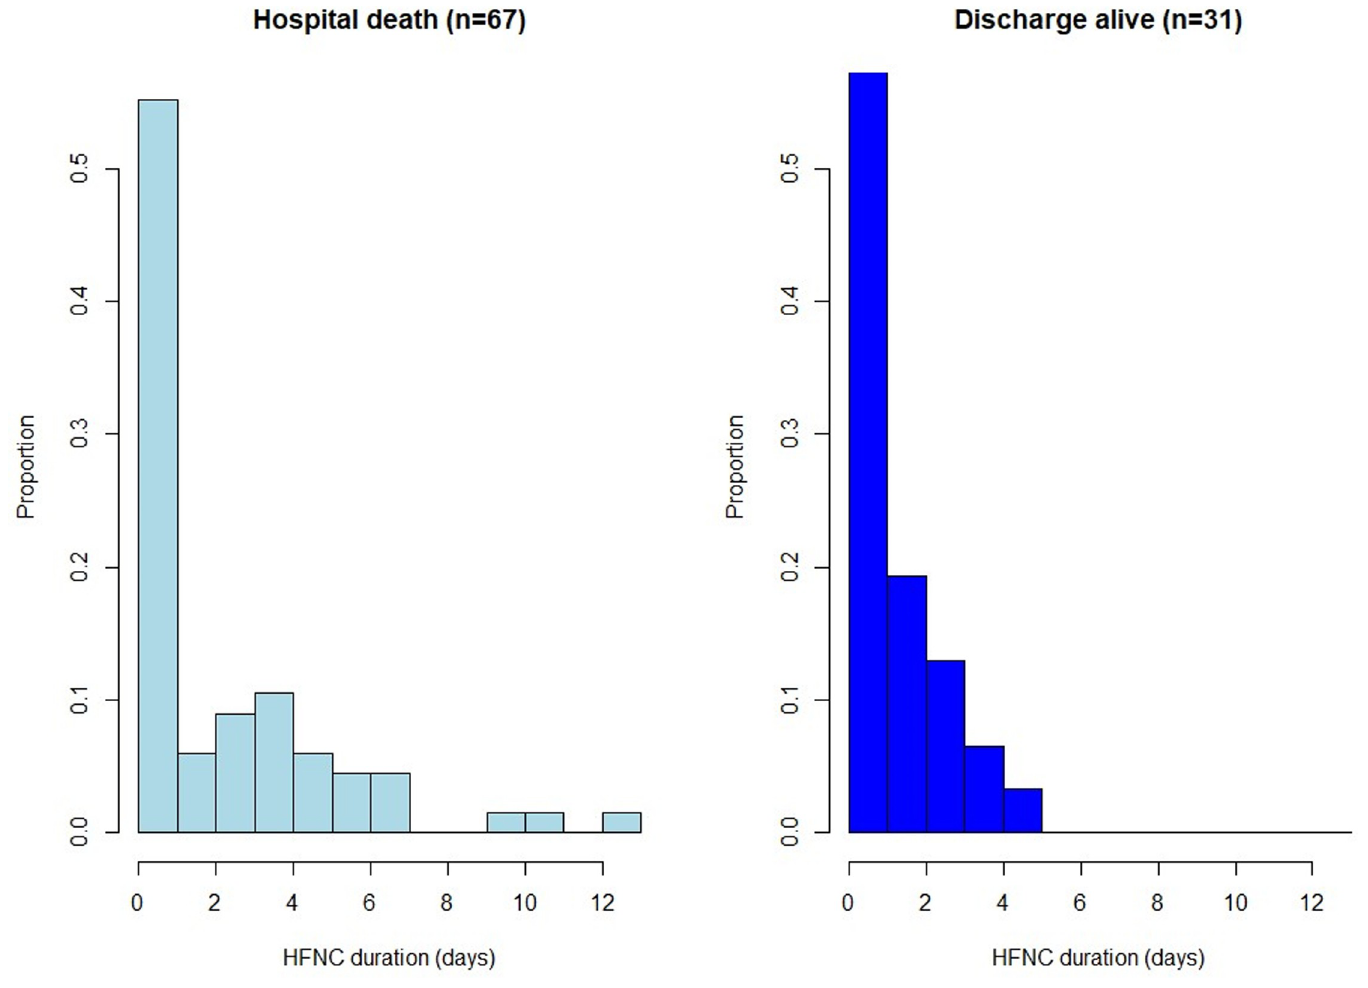
Fig 2. Hospital mortality and survival according to duration of HFNC